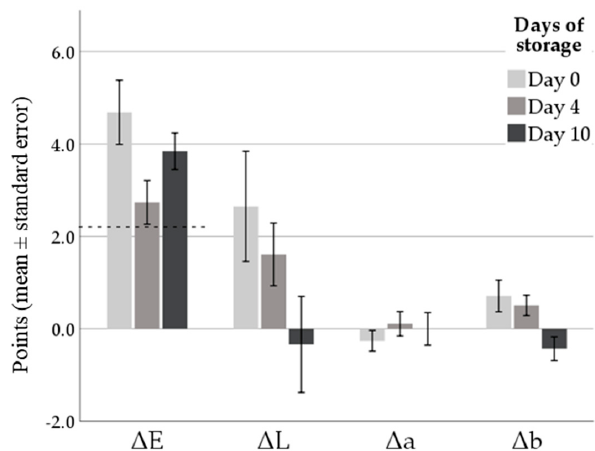
Figure 1. Effects of Goji berries inclusion in the diet of rabbits on meat color. Total color difference ( Δ E) and differences in lightness ( Δ L), redness ( Δ a), and yellowness ( Δ b) between groups (control – Goji) at slaughtering and at day 4 and 10 of shelf-life. The dashed line indicates the threshold of human noticeable differences for (>2.3 points) for Δ E.